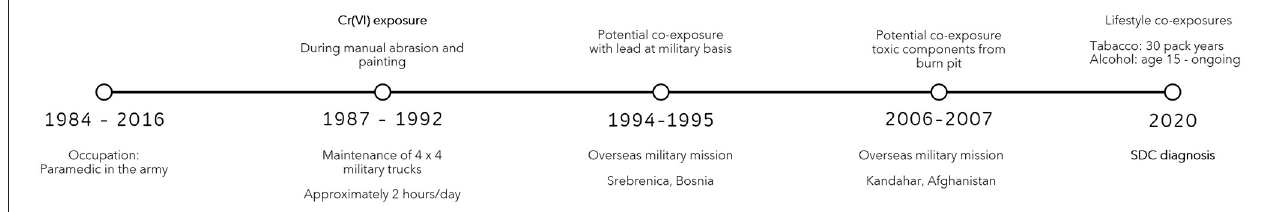
FIGURE 6 | Time-line of case report